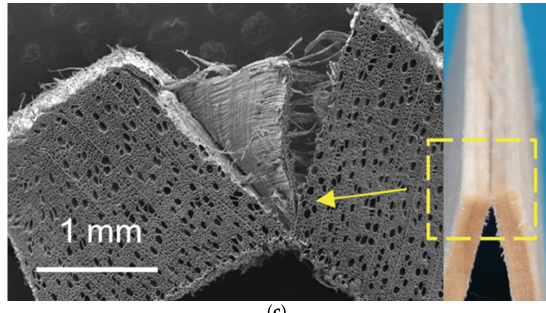
Figure 38. ( a ) Shear localization in a block of wood compressed longitudinally and parallel to the cellular structure. From [79]. ( b ) Example of shear fracture due to tensile loading of Pinus koraiensis . From [85]. ( c ) SEM and optical image of natural wood broken by bending. From [165].